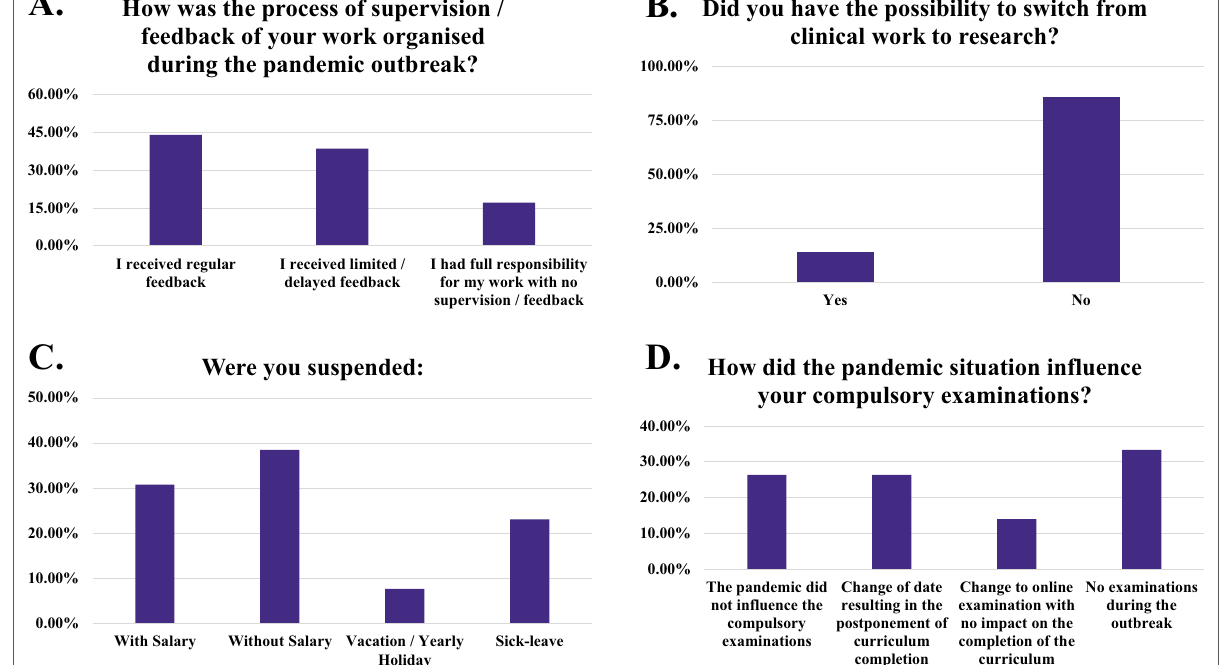
Fig. 5 Responses to questions aiming to collect information about changes in radiological education during the pandemic. The questions assessed changes in supervision ( A ), the possibility to switch from clinical to research work ( B ), whether the trainees were suspended ( C ) and whether the outbreak affected compulsory examinations ( D